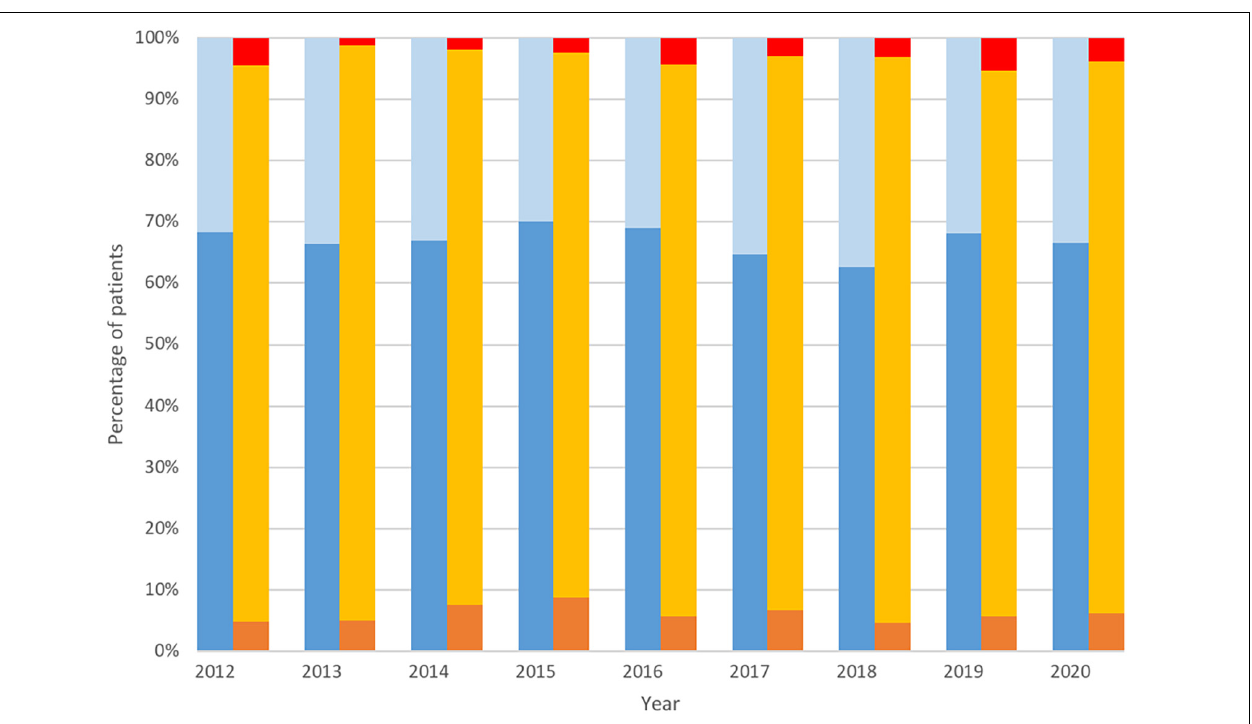
FIGURE 1 | Temporal trends in completeness of revascularization and utilization of arterial grafting. Complete revascularization (dark blue), non-complete revascularization (light blue), multiple arterial grafting (orange), single arterial grafting (yellow), total arterial revascularization (red).